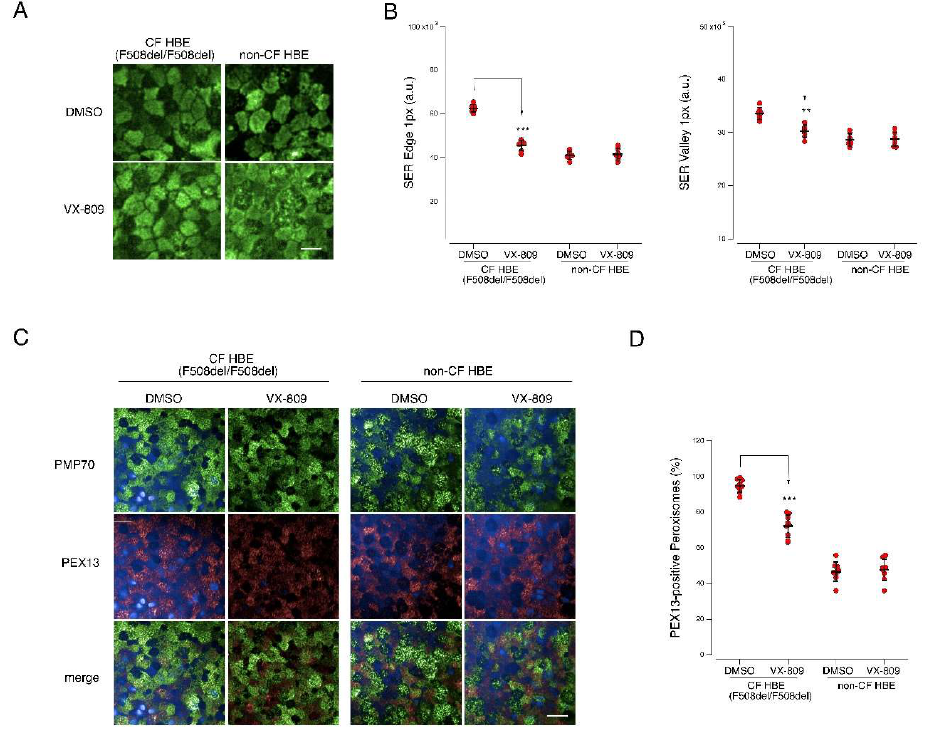
Figure 7. Analysis of mitochondrial network morphology and peroxisomal distribution in CF and non-CF bronchial epithelia. Well-differentiated bronchial epithelia were generated from two F508del/F508del homozygous CF patients (donor ID: BE49 and BE55) and two non-CF subjects